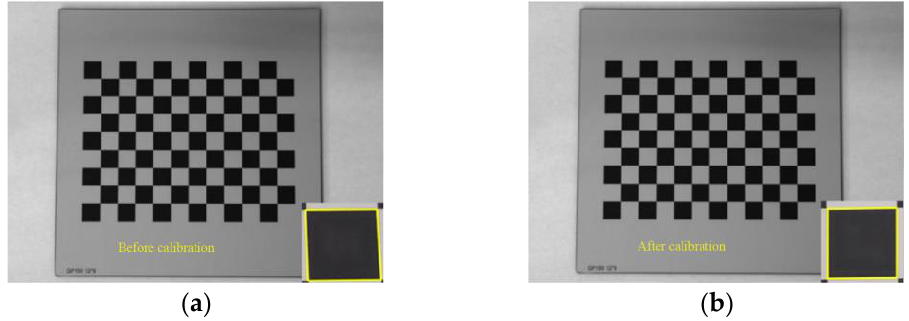
Figure 5. Camera calibration image: ( a ) before calibration and ( b ) after calibration.